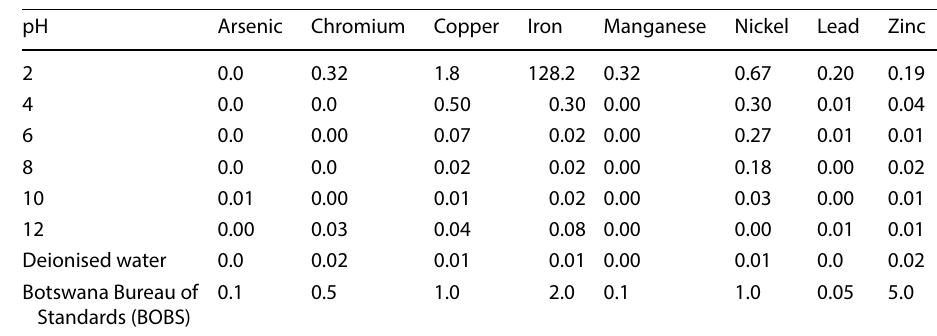
Table 5 Leachability of heavy metals from treated copper smelter slag at different pH values